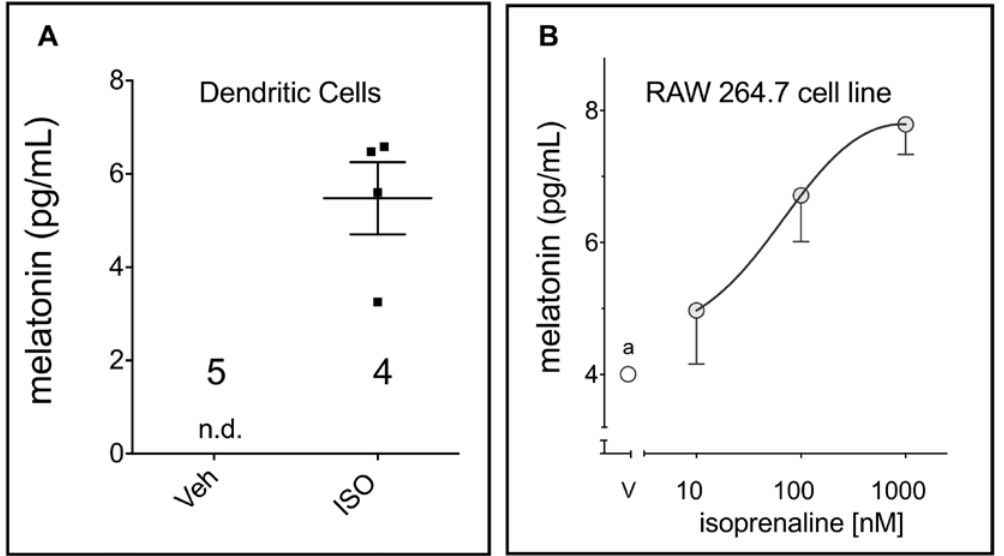
Figure 1. β -adrenoceptor triggers melatonin synthesis in phagocytes . ( A ) Bone marrow dendritic cells (isoprenaline, ISO, 10 µM, 24 h; n.d., not detected); the values for each replicate and the mean ± SEM are shown in the graph. ( B ) RAW 264.7 macrophages isoprenaline 3 h (a)—vehicle = 4.0 ± 0.01, the melatonin ELISA kit detection limit is quoted as 3–4 pg/mL). Data are shown as mean ± SEM of three independent experiments.